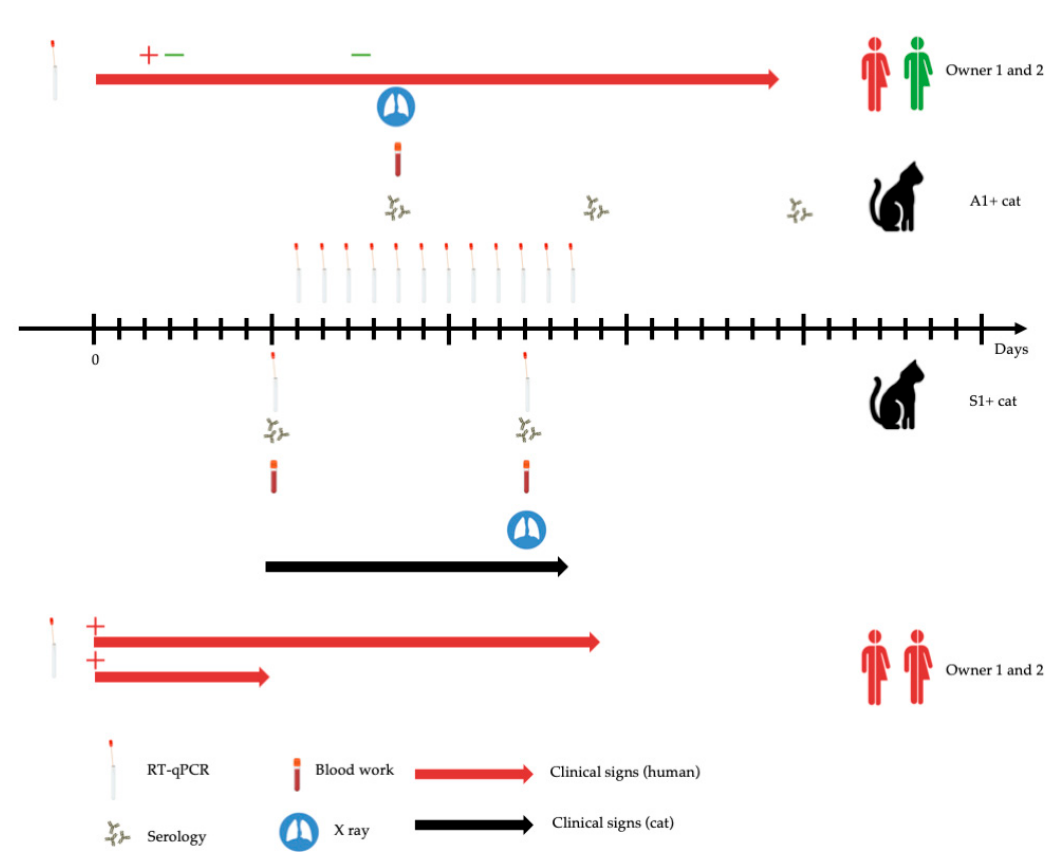
Figure 2. Timeline of the sample collections, clinical exams, and tests in S1+ and A1+ cats. Each household (including animals and their owners) is represented on either side of the timeline. qRT-PCR, serology, blood work, and X-ray pictograms represent the day when the test was performed. For humans, “+” and “ − ” represent a positive and negative qRT-PCR test, respectively.